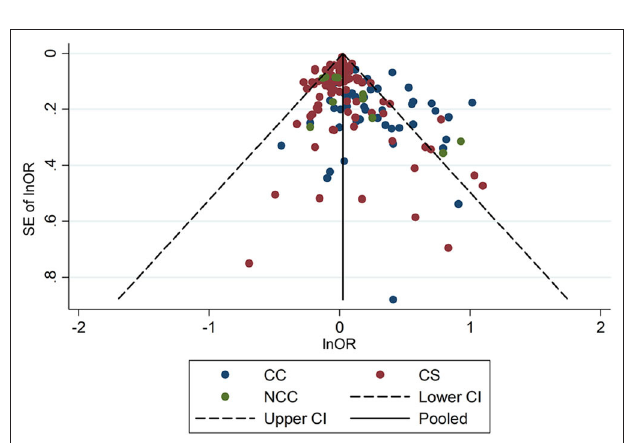
FIGURE 5 | Funnel plot for publication bias